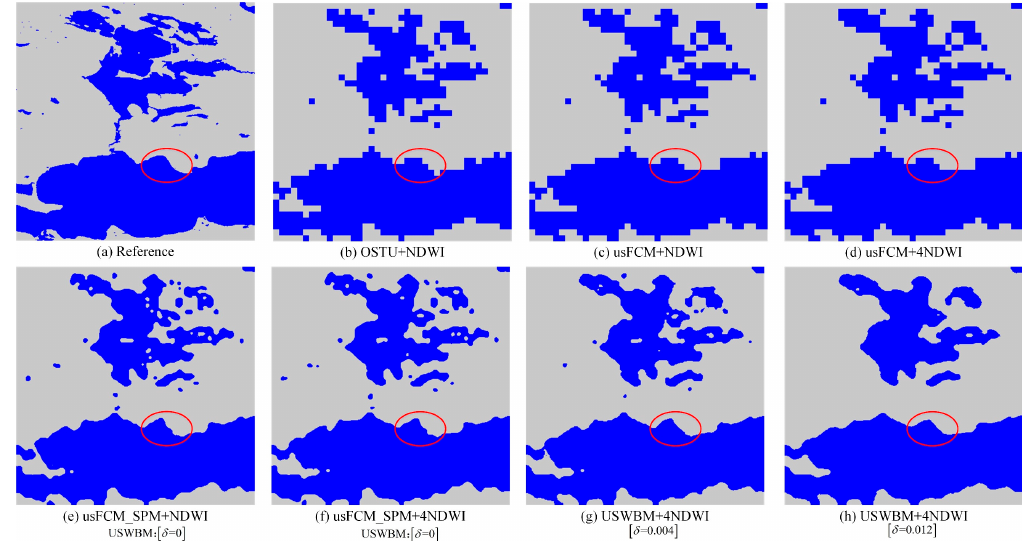
Figure 6. Water body maps generated by different algorithms for Tibet Plate lake. ( a ) Reference water body map; ( b ) Water body map produced from the NDWI image (based on NIR band 17) by using OSTU segmentation; ( c ) Water body map produced from the NDWI image by using usFCM segmentation; ( d ) Water body map produced from the four integrated NDWI images by using usFCM segmentation; ( e ) Water body map produced from the NDWI images by using usFCM_SPM segmentation; ( f ) Water body map produced from the four integrated NDWI images by using usFCM_SPM segmentation; ( g , h ) Water body map produced from the four integrated NDWI images by using the proposed USWBM algorithm when δ was 0.004 and 0.012, respectively.